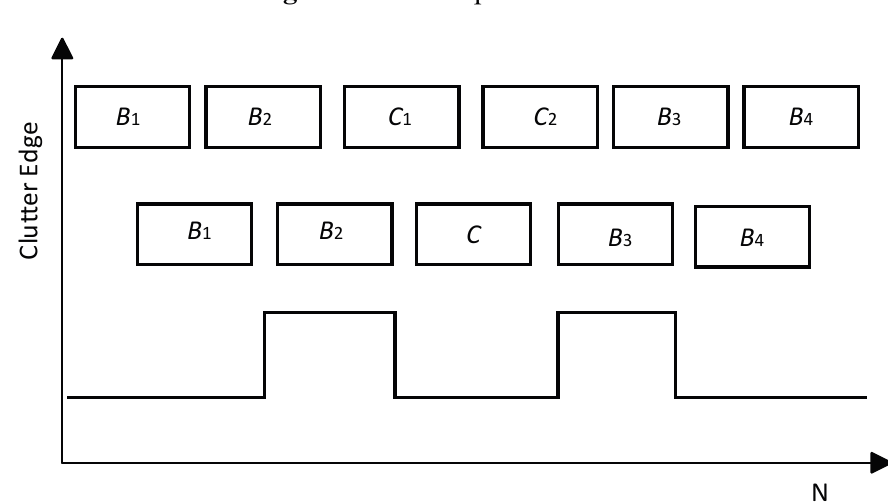
Figure 2. Double partition test.